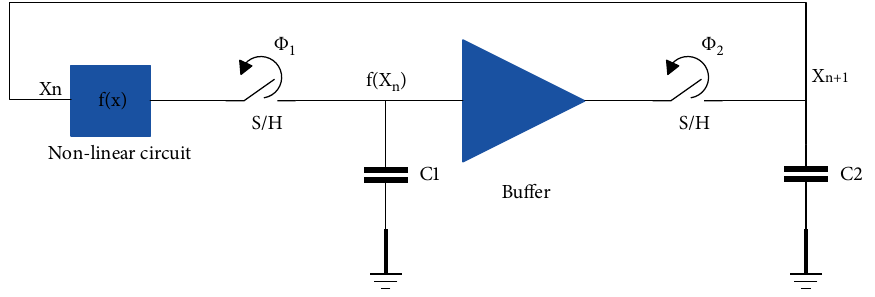
Figure 7: A common structure of discrete-time chaotic